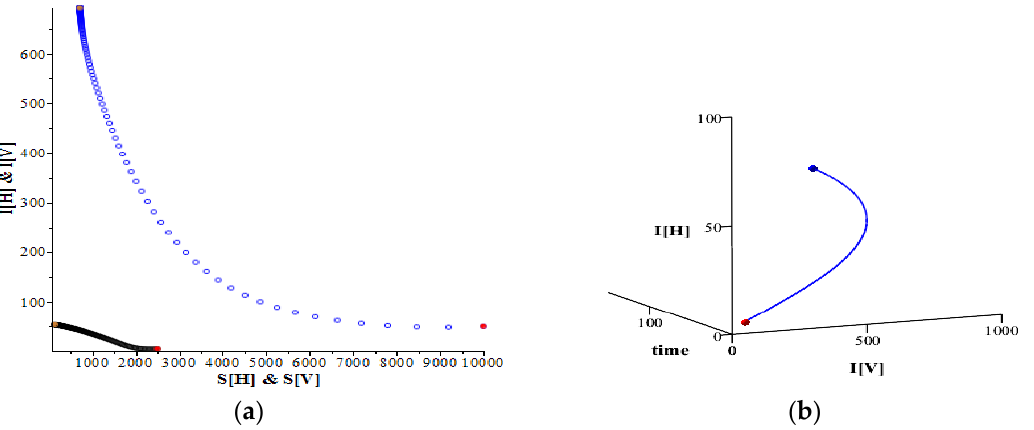
Figure 2. The phase port of S H ( t ) and I H ( t ) (black) and the phase port of S V ( t ) I V ( t ) (blue) are shown in ( a ). ( b ) shows the trajectory of I H ( t ) and I V ( t ) in a 3D graph. The red dots in both figures indicate the initial values of the system. The parameters are the same as in Figure 1.